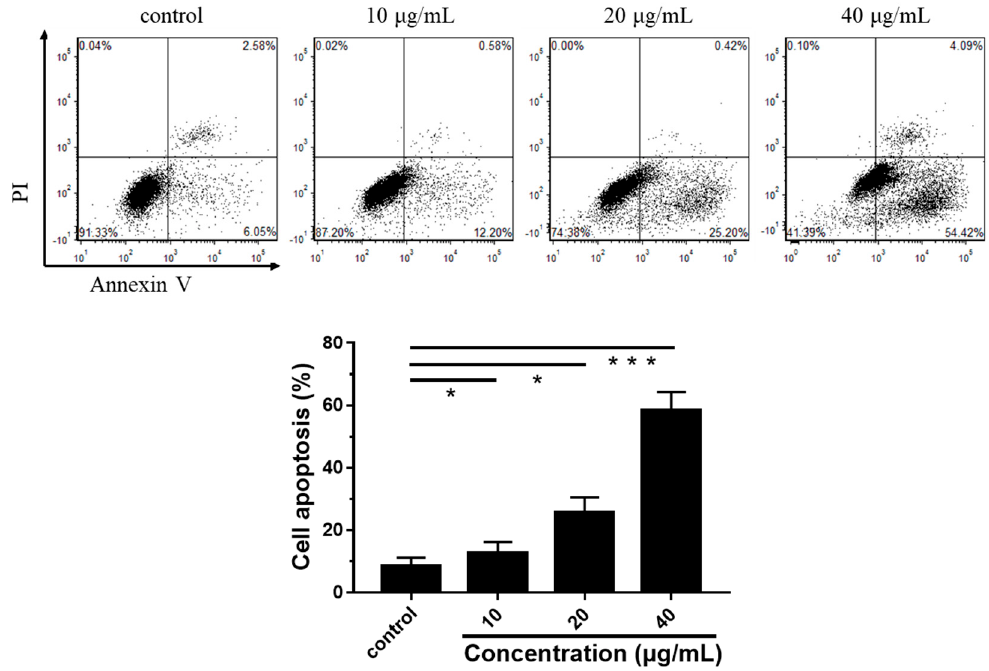
Figure 3. Flow cytometric analysis of cell apoptosis induced by treatment with LEGCG for 24 h on DU145 cells. *, 0.01 < p < 0.05, **, 0.001 < p < 0.01, ***, p <